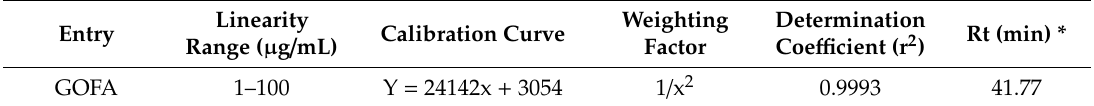
Table 1. Mean linear calibration curve parameters obtained by weighted linear least-squares regression analysis of three independent twelve non-zero concentration point.